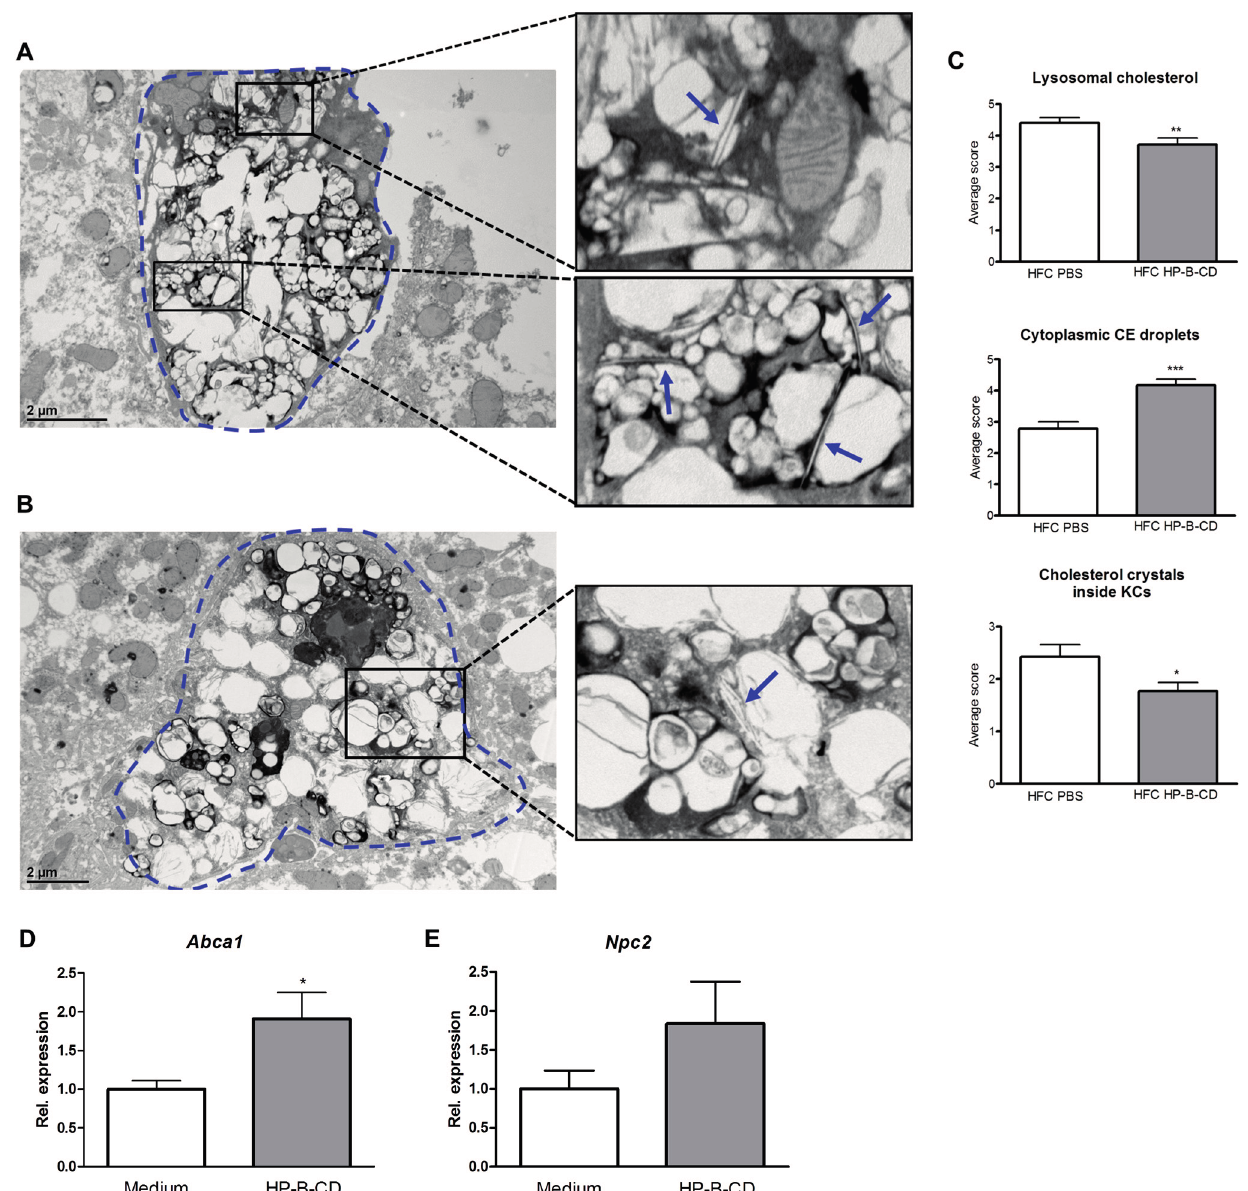
Figure 3. Effect of HP-B-CD on intracellular cholesterol distribution and cholesterol transporters. Representative electron microscopy pictures of Kupffer cells (KCs) of HFC-fed Ldlr − / − mice without ( A ) and with HP-B-CD treatment ( B ). Lysosomes are indicated in black by ACPase staining. KCs are depicted by the dashed line. Arrows point to cholesterol crystals; ( C ) Scoring of lysosomal cholesterol, cytoplasmic cholesteryl ester (CE) droplets and cholesterol crystals after 12 weeks of HFC diet. In total, 40 to 50 KCs were scored per HFC group and an average score was calculated. Gene expression levels of the cholesterol transporters Abca1 ( D ) and Npc2 ( E ) in oxLDL-loaded BMDM with or without HP-B-CD treatment. The in vitro results are the mean ± SEM from two separate experiments performed in triplicate. * Significantly different from control. * , ** and *** indicate p < 0.05, 0.01 and 0.001,